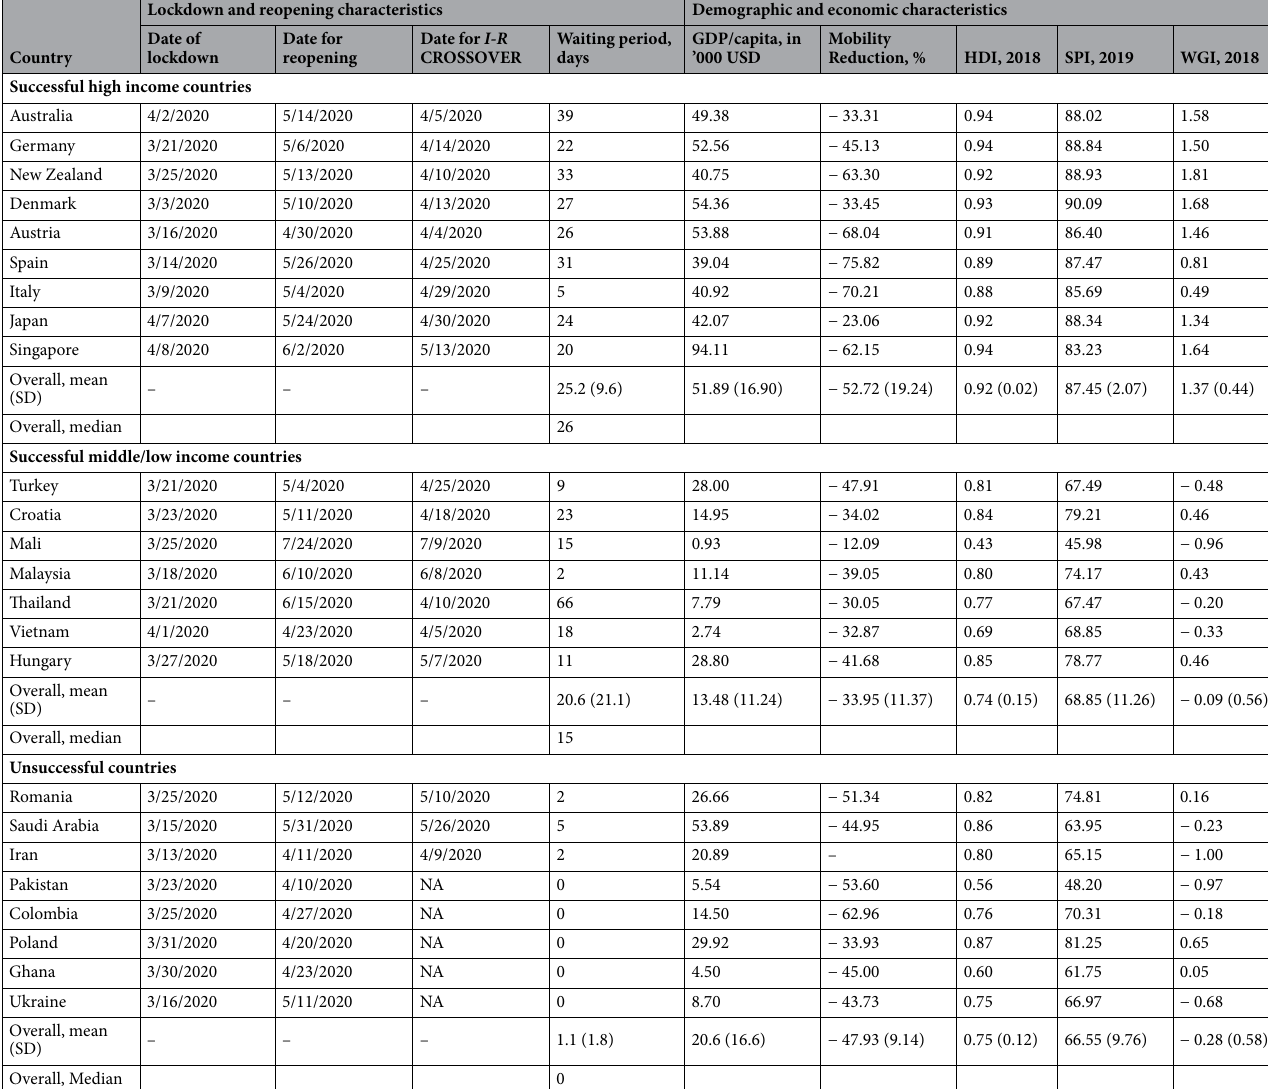
Table 1. Lockdown, reopening, demographic, and economic characteristics of the 24 countries included in the study. Mobility reduction during lockdown is calculated from the Google Mobility reports for each country. I-R crossover denotes time point when the daily recovery rate exceeds the daily new case rate. I-R infection- recovery; GDP gross domestic product; HDI human development index; SPI social progress index; WGI world governance indicator; SD standard deviation; NA not applicable.